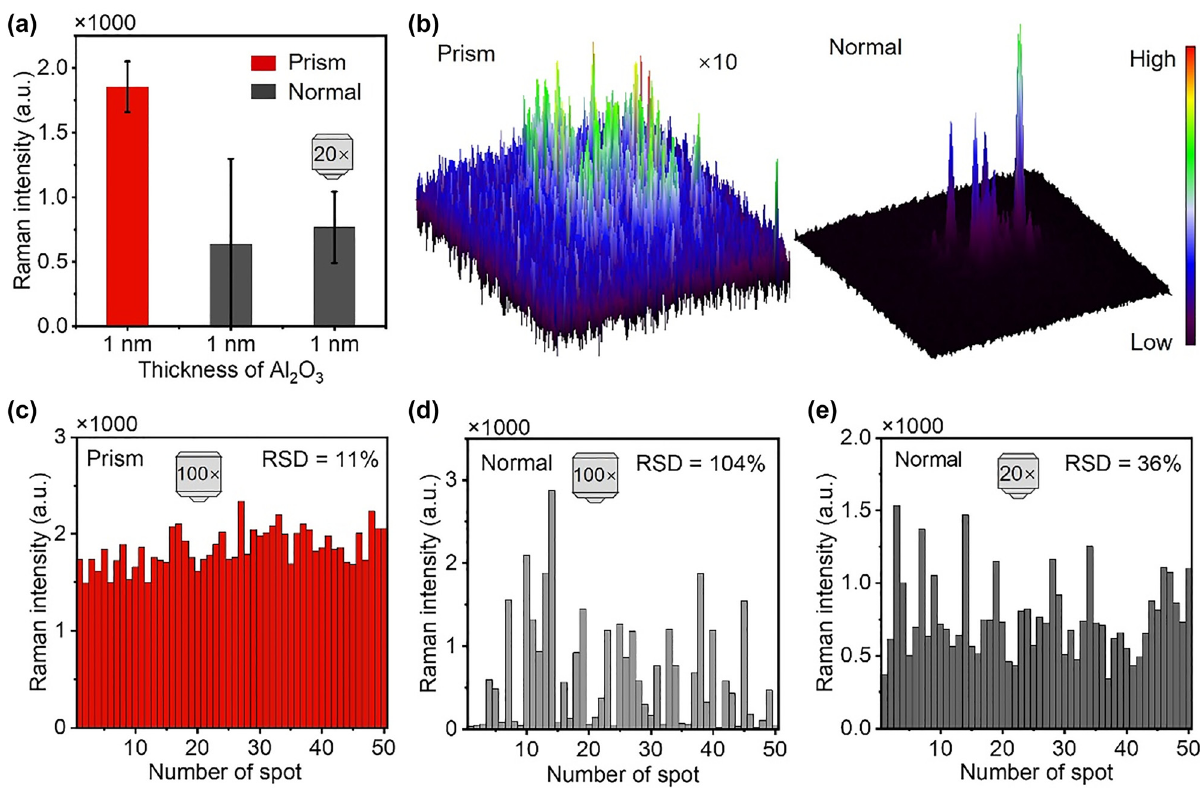
Figure 2: Comparing the uniformity of SERS enhancement. (a) SERS intensities of 4-MBA molecules at 1075 cm − 1 under prism excitation and normal excitation. Error bars indicate the standard deviations of 50 measurements. (b) Raman images at 1075 cm − 1 under prism (left) and normal excitation (right). (c–e) SERS intensities at 1075 cm − 1 of 50 SERS spectra recorded under prism excitation (c), normal excitation with 100 × objective (d) and 20 × objective